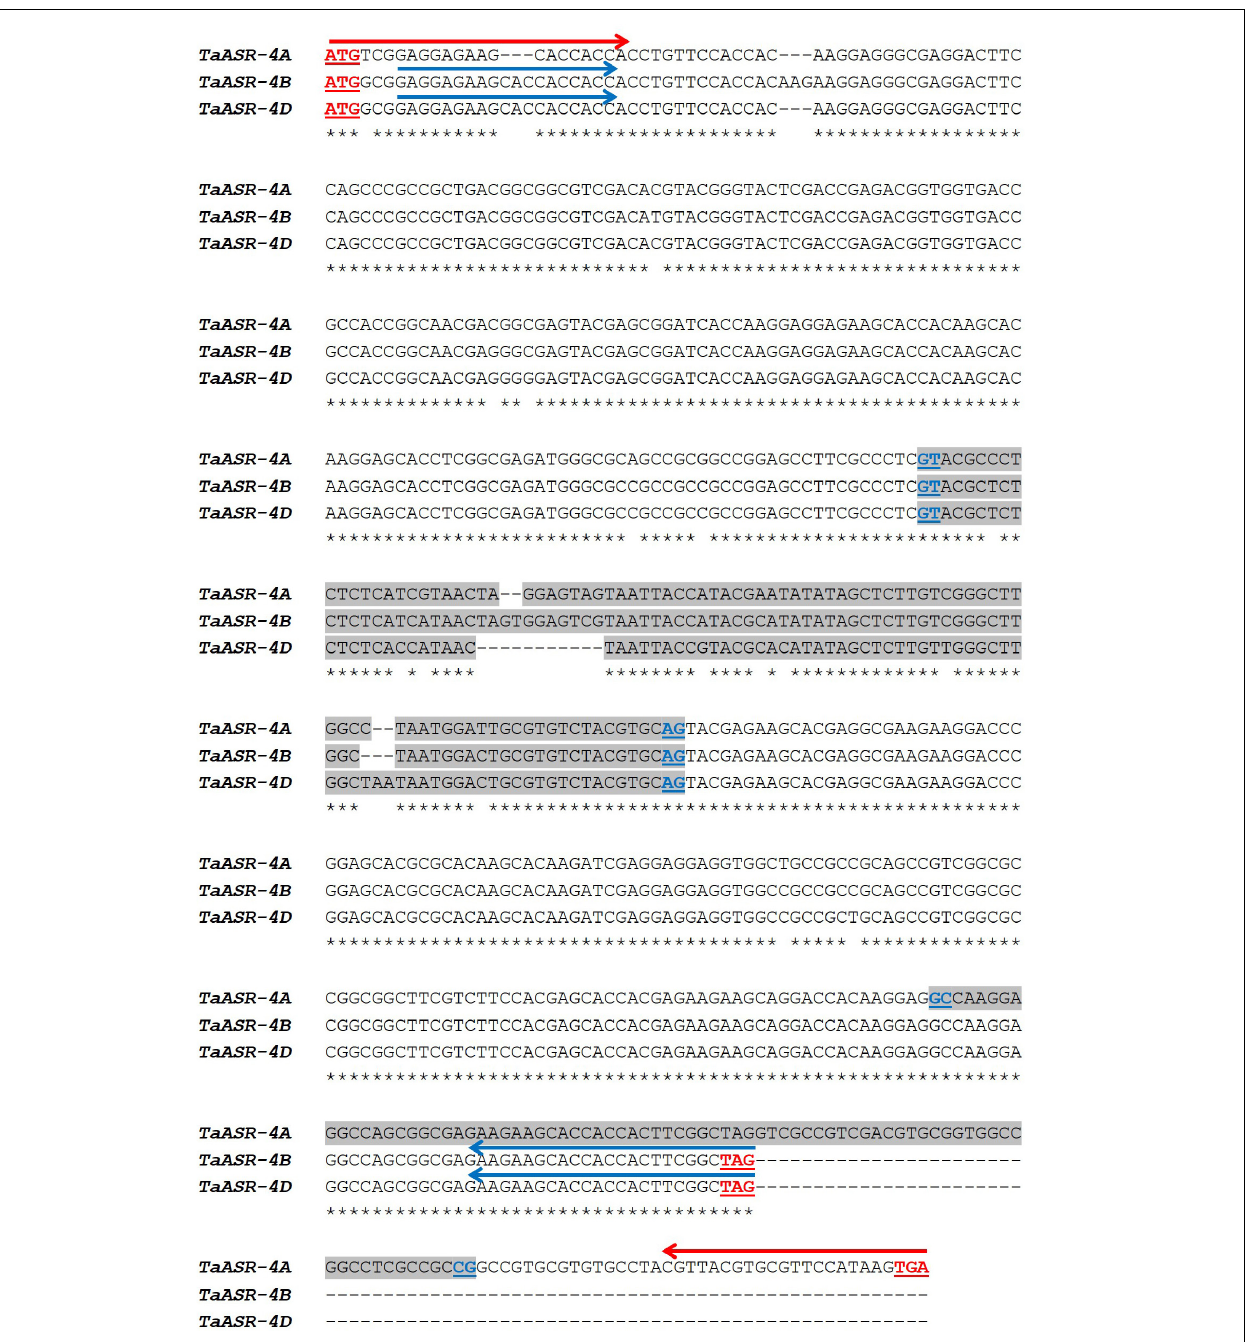
FIGURE 2 | Multiple alignments of common wheat ( Triticum aestivum cv. Chinese Spring) homoeologous TaASR genes on 4A, 4B, and 4D chromosomes. Intron sequences are highlighted in gray. Underlined in red are reported the start and stop codons; underlined in dark blue are reported the splice junctions. Arrows represent primer pairs picked for gene amplification in Real-Time qRT PCR expression studies (red = P1; blue = P2). P1 is the specific primer pair for the A genome; P2 simultaneously amplifies TaASR homoeologous genes from 4B and 4D chromosomes.